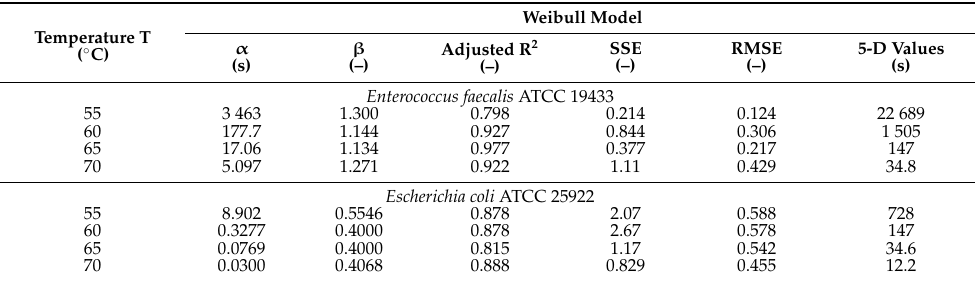
Table 1. Modeling results of thermal inactivation kinetics of two indicator bacteria using Weibull model.